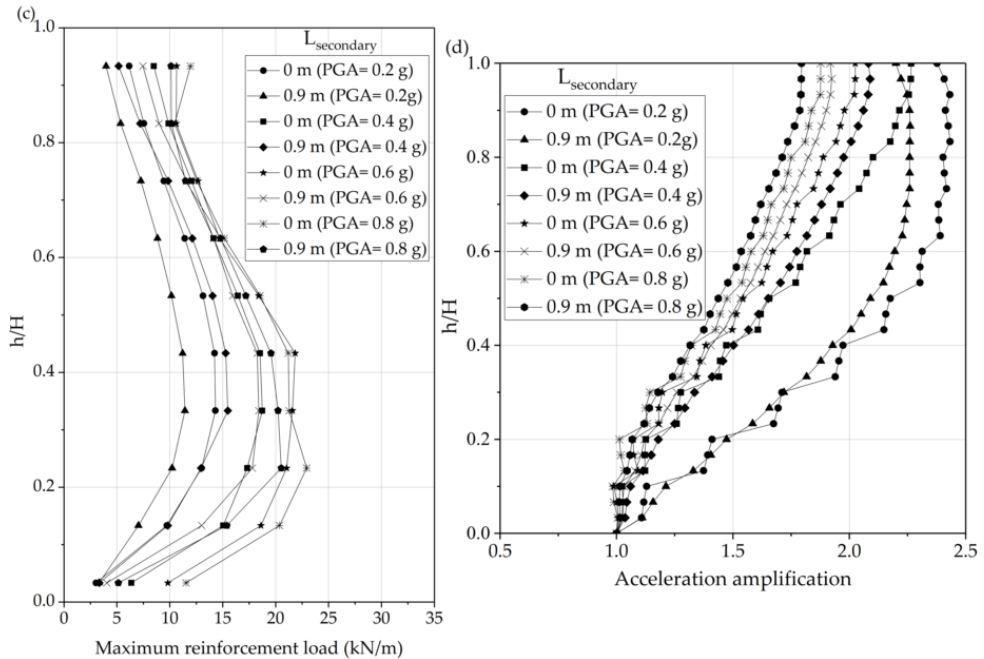
Figure 19. The effect of PGA on ( a ) the relative lateral displacement; ( b ) connection load; ( c ) maximum reinforcement load; ( d ) acceleration amplification of walls with and without secondary reinforcement.